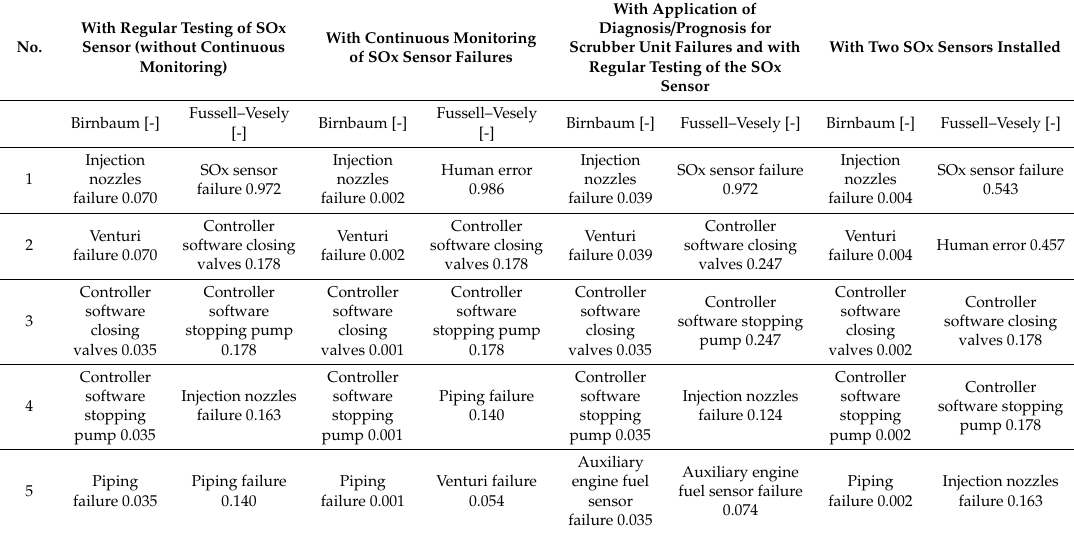
Table 9. Importance analysis